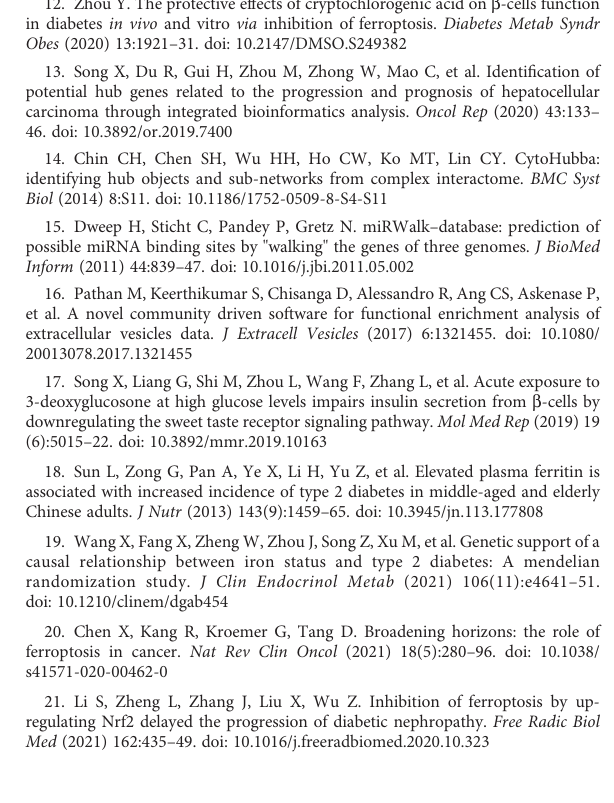
SUPPLEMENTARY TABLE 1 Signi fi cantly differentially expressed mRNA in GSE25724. SUPPLEMENTARY TABLE 2 Gene Set Enrichment Analysis results for the gene expression data in GSE25724. SUPPLEMENTARY TABLE 3 Predicted miRNA for fi ve hub